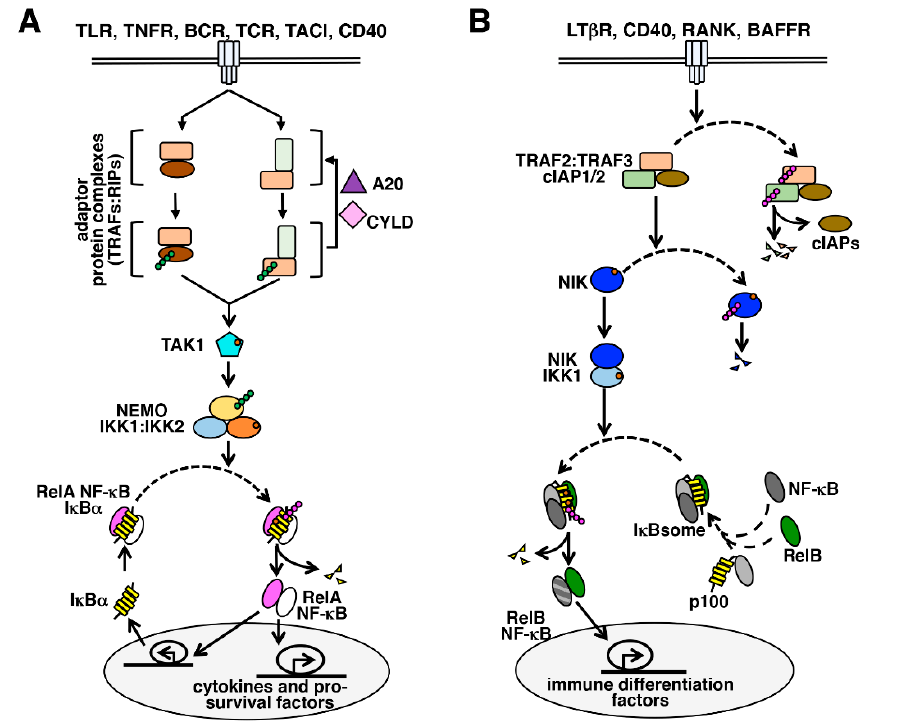
Figure 2. NF- κ B activating pathways. The NF- κ B system consists of ( A ) the canonical and ( B ) the non-canonical pathways. In general, immune-activating cues activate the canonical pathway, which stimulates the synthesis of pro-inflammatory and pro-survival factors involving the RelA NF- κ B activity; and non-canonical signaling triggers RelB NF- κ B activation during immune differentiation.